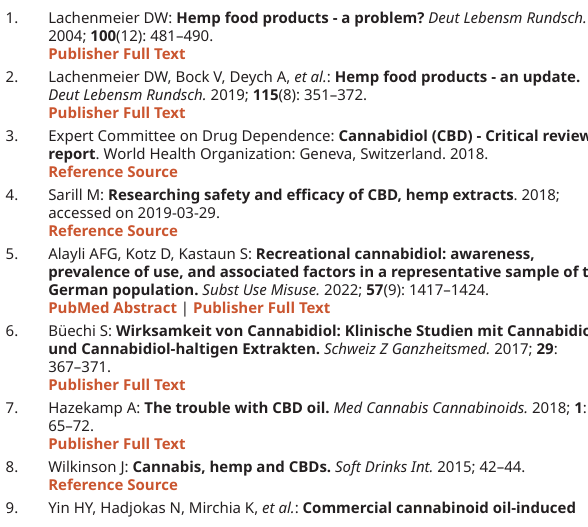
spreadsheet with data underlying Table 1 and Table